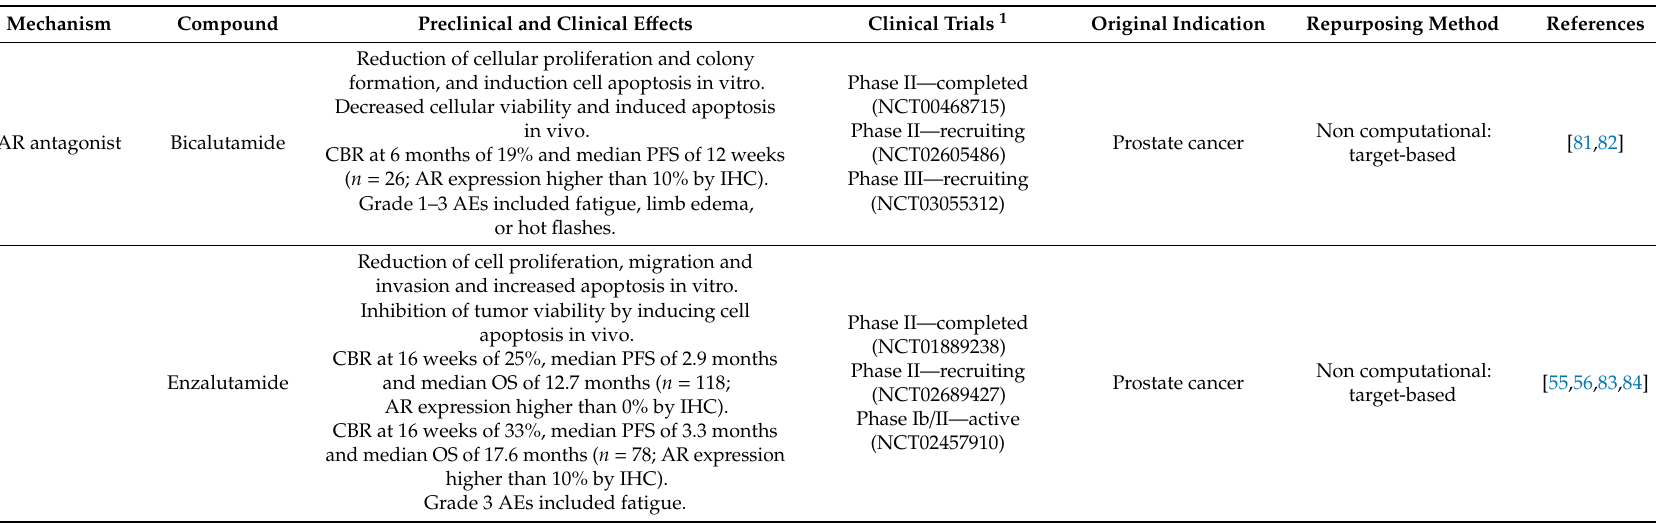
Table 4. Summarized repurposed drugs for TNBC under current investigation in clinical